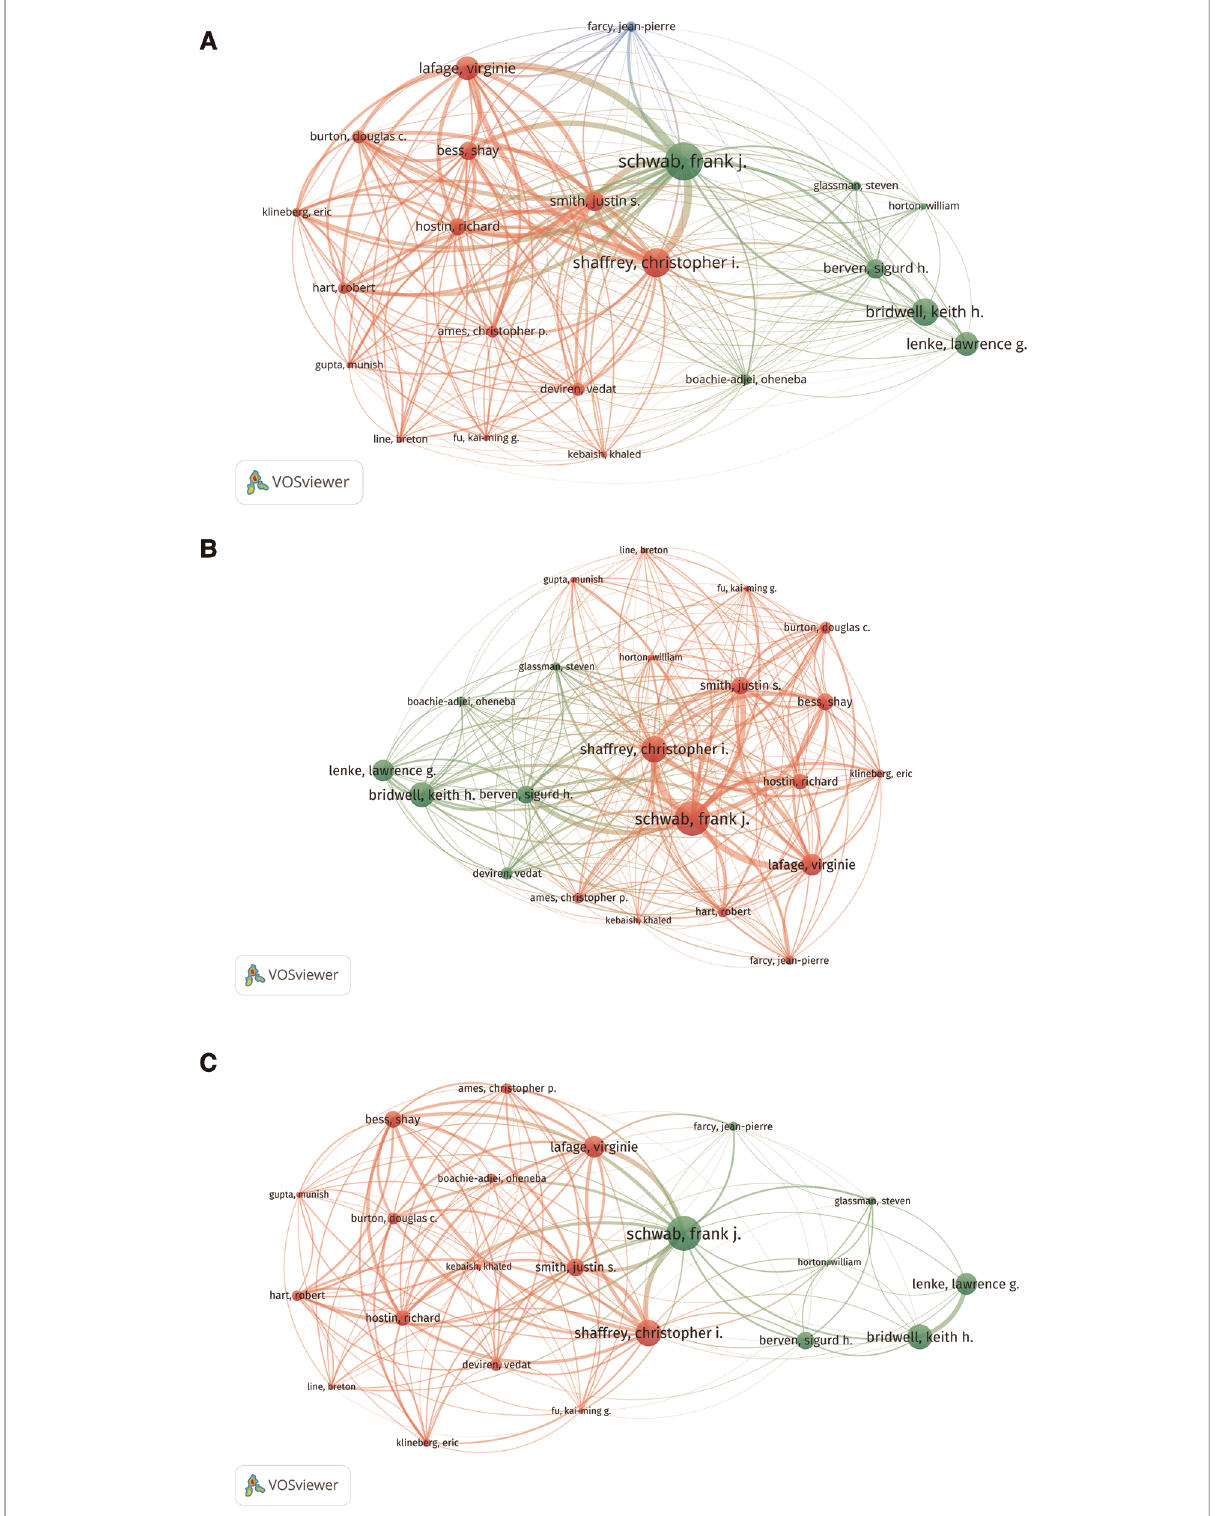
FIGURE 8 Visual mapping of the authors ’ relationships. Bibliographic coupling analysis of authors from the top 100 most-cited articles on ASD ( A ); citation analysis of authors from the top 100 most-cited articles on ASD ( B ); co-authorship analysis of authors from the top 100 most-cited articles on ASD ( C